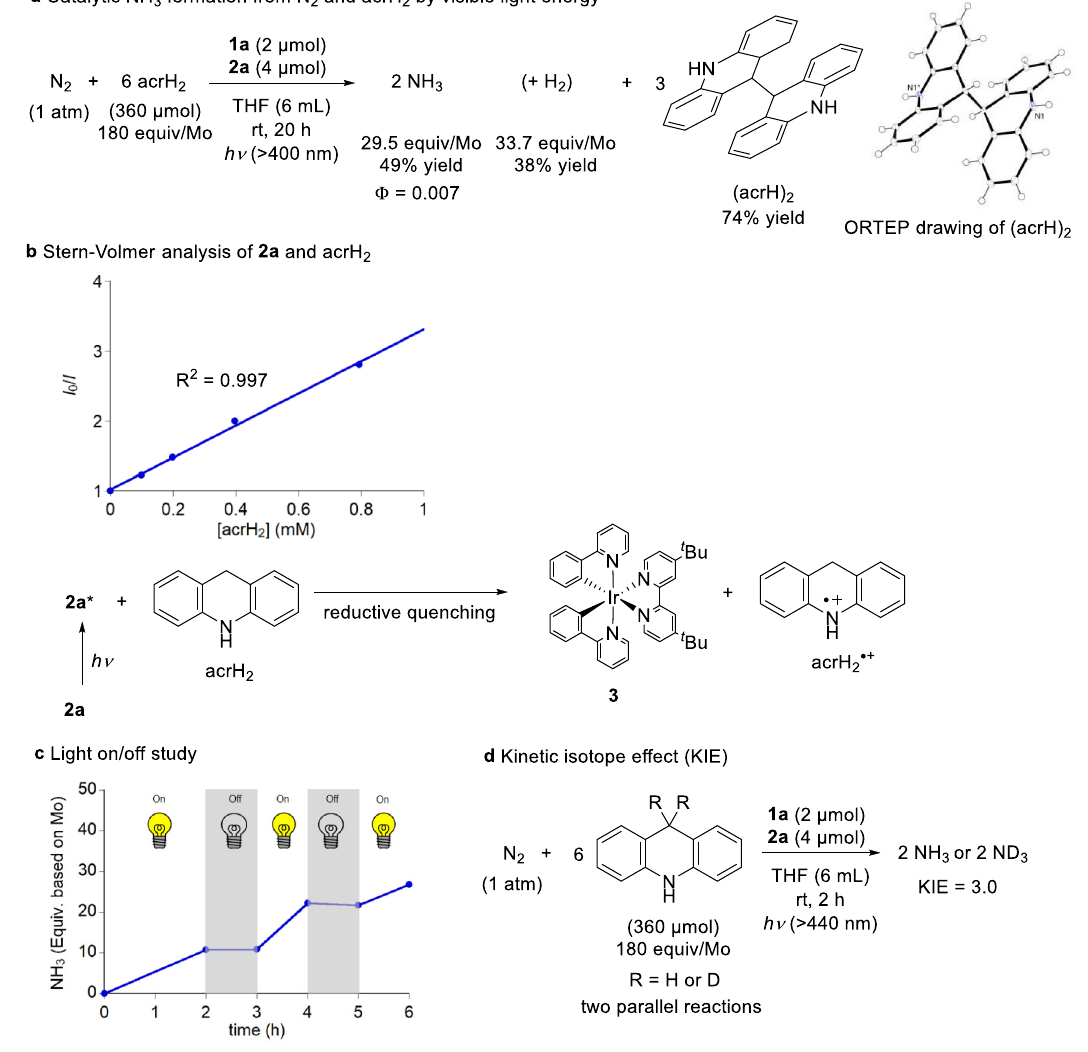
Fig.2|Catalyticnitrogen fi xationusingvisiblelight.a Ammoniaformationfrom dinitrogen and acrH 2 in the presenceof molybdenum complex 1a and photoredox catalyst 2a . b Emissionquenchingexperimentofphotoredoxcatalyst 2a withacrH 2